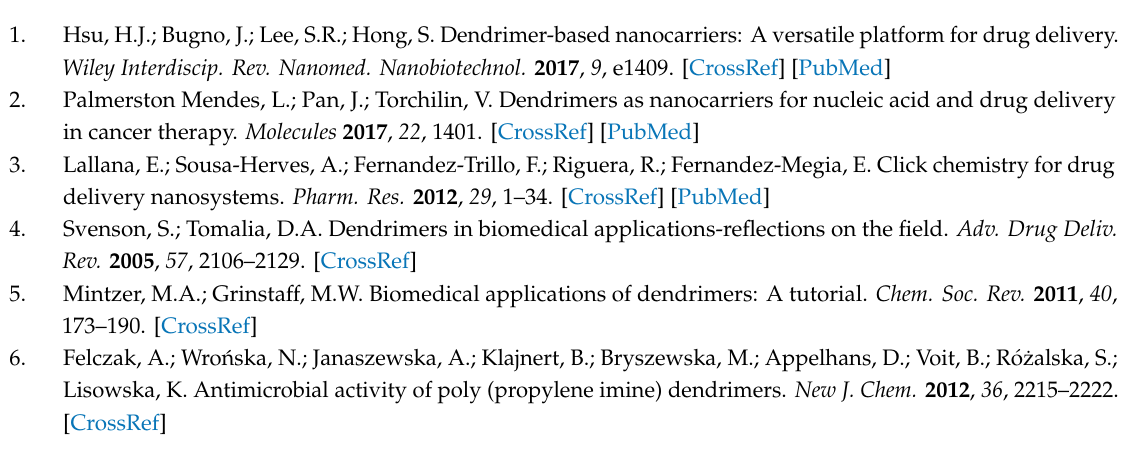
Supplementary Materials: The following are available online. Figure S1: The principal scheme of the synthesis of Lys-2His dendrimer from the core to the first generation, Figure S2: 1 H- 13 C HSQC spectrum of Lys-2His dendrimer in D 2 O at 25 ◦ C. The letter symbols correspond to the designations of the groups in Figure 2, Figure S3: ◦ C at the range from 5.0 ppm to 1.0 ppm. The letter 1 H- 13 C HMBC spectrum of Lys-2His dendrimer in D 2 O at 25 symbols correspond to the designations of the groups in Figure 1, Figure S4: 1 H- 13 C HMBC spectrum of Lys-2His dendrimer in D 2 O at 25 ◦ C at the range from 8.5 ppm to 6.5 ppm. The letter symbols correspond to the designations of the groups in Figure